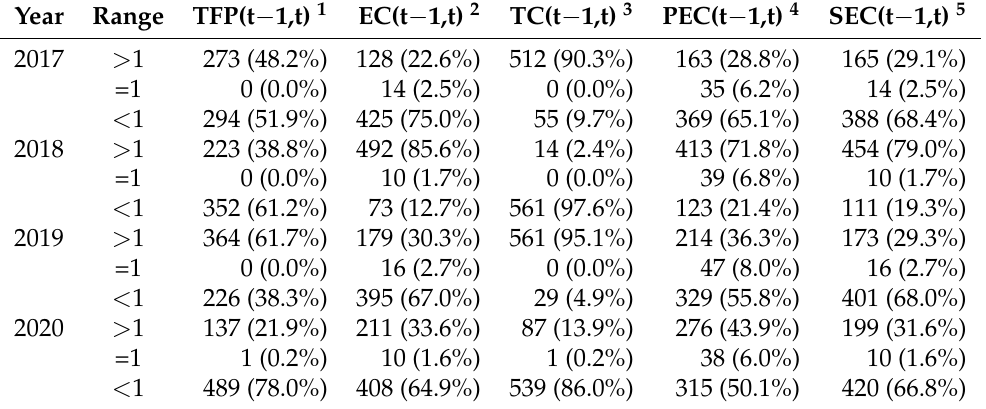
Table 6. Frequency distribution of the Malmquist index of PHCI in Shenzhen from 2017 to